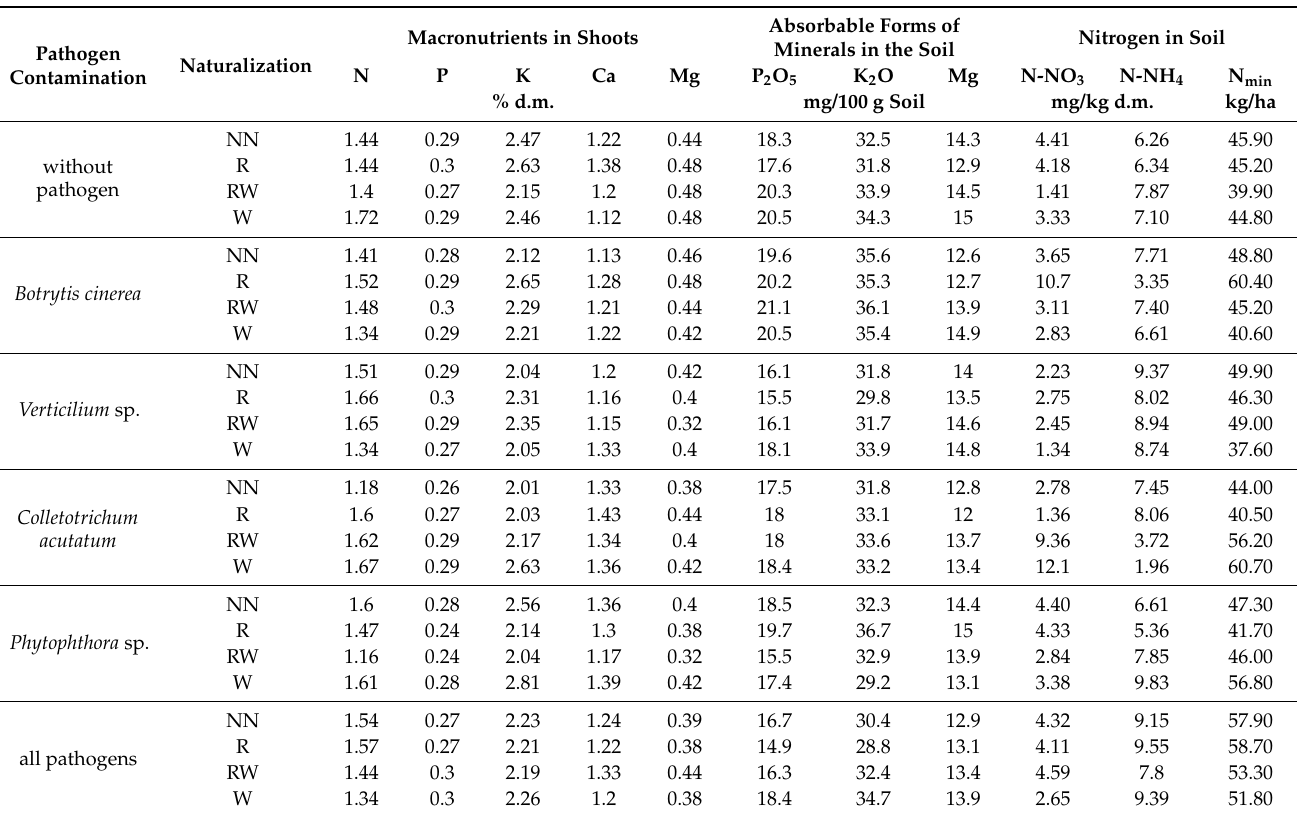
Table 5. The effect of the bacterial consortium on the macronutrient amount in the plant, root and in the soil samples depends on the pathosystem and naturalization strategy applied. The amount of macronutrients varied according to the pathosystem used, Botrytis cinerea , Verticillium sp., Colletotrichum acutatum , Phytophthora sp. and all pathogens ( Botrytis , Verticillium , Colletotrichum , Phytophthora ) and without pathogens, within different biopreparation application strategies: no naturalization (NN), root inoculations (R), root inoculations and watering (RW), and watering